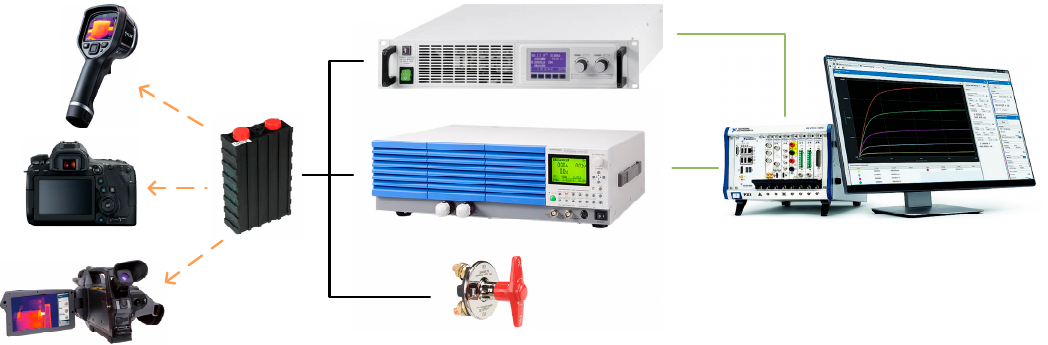
Figure 1. Block diagram of experimental test set-up for selected battery testing.